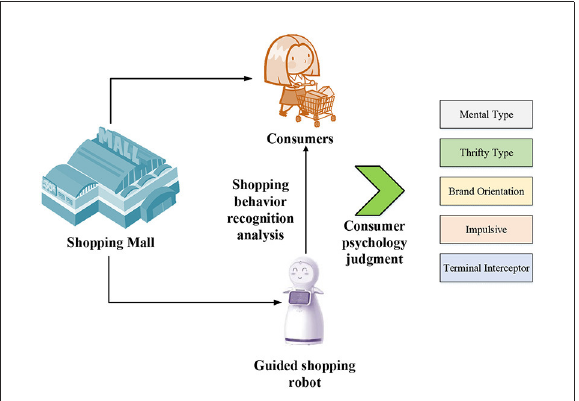
FIGURE1 Psychological analysis and type judgment of consumer